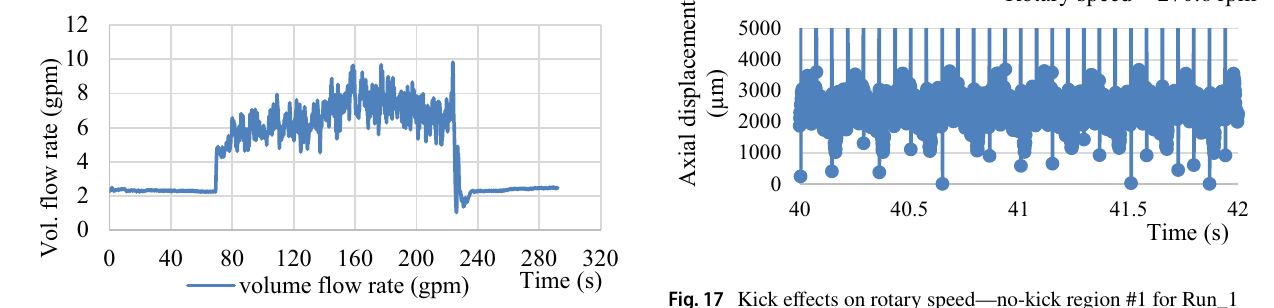
Fig. 15 Effects of gas kick on volume flow rate of the return fluid for experimental Run_2